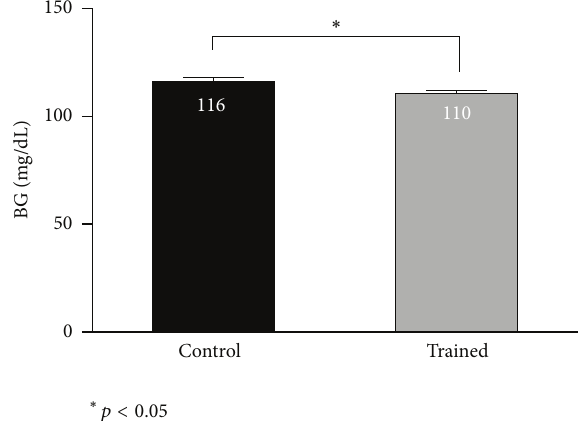
Figure 2: Average glycemic values in diabetes-free NOD mice in the time-window 6–12 weeks of training. Results are shown as means and